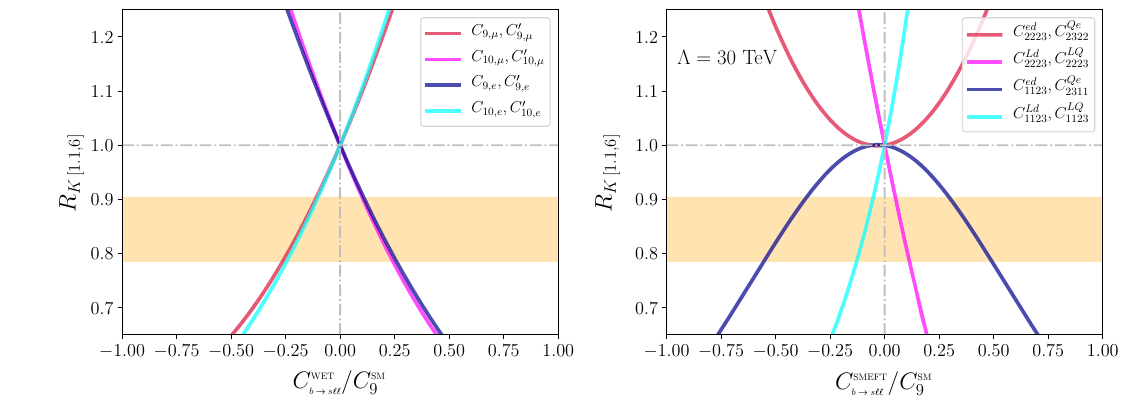
Fig. 1 The impact on R K of each of the NP operators in the two EFT frameworks considered. The orange band highlights the new R K mea- surement, while the dashed-dot silver lines mark the SM value. In both NP orthogonal to what outlined from the R K anatomy.